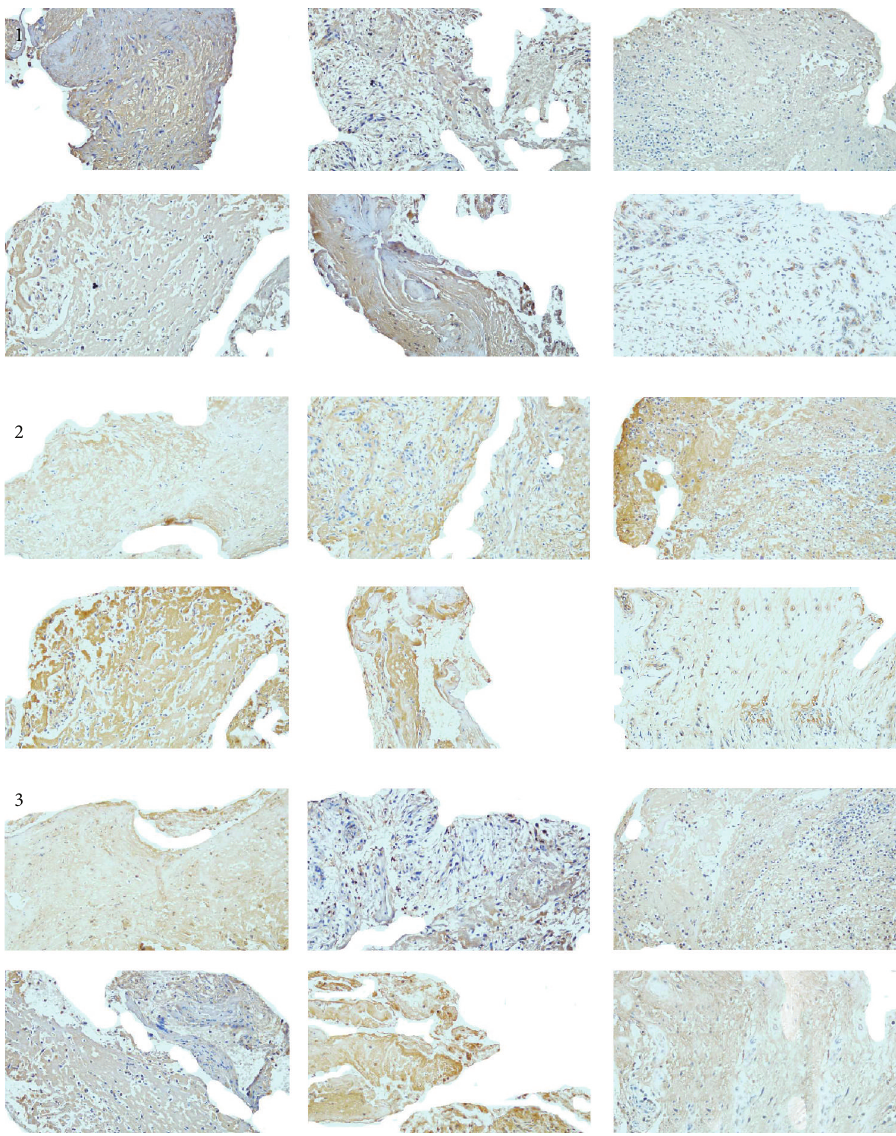
Figure 3: Dynamic changes on the expression of each target protein in granulation tissue before and within 15 days after the APG application. Note: the images captured from sections present the dynamic changes of each target protein within 15 days after the first APG application. The immunoreactants in the images from number 1 to 3 were MMP-2, TIMP-2, and TGF- 𝛽 1 one by one. Each number of images includes 6 parts, which were taken at the d0, d3, d6, d9, d12, and d15 from left to right. The expression of MMP-2 was suppressed after APG treatment and that of TIMP-2 was promoted by APG treatment, and levels at each observation point were higher than baseline before the d12, with the peak appearing at about the d9–12. TGF- 𝛽 1 was promoted also, and the peak came out at the